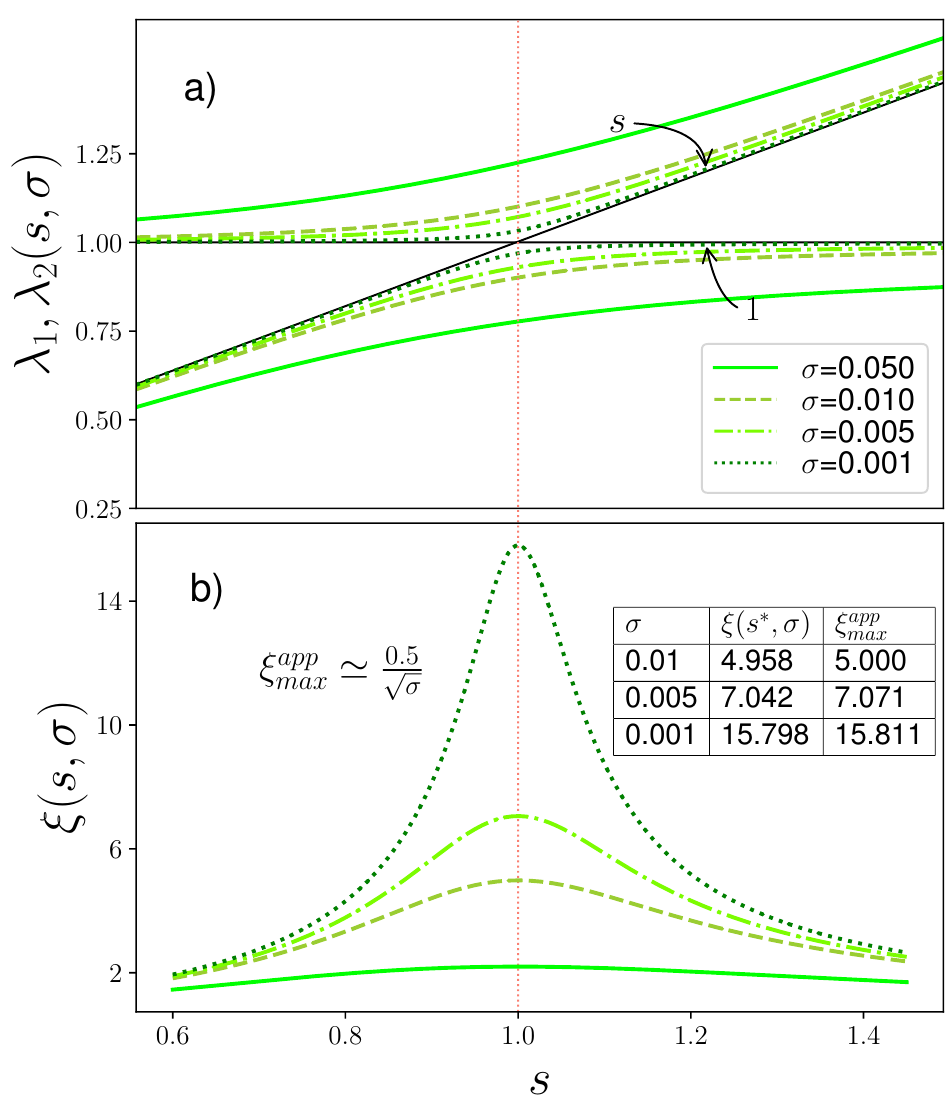
Figure 1. Eigenvalue analysis for Zimm–Bragg model over a range of stability parameter s at different values of cooperativity parameter σ . Transition point can be approximated as s ∗ = 1. ( a ) Eigenvalues (defined by Equation (12)) have asymptots s + σ and 1 lines shown instead visualize limiting (at σ shown in the inset are valid throughout the picture. ( b ) Spatial correlation length ξ (defined by Equation (17)) is a curve with maximum, that scales as ξ app max between exact and approximate